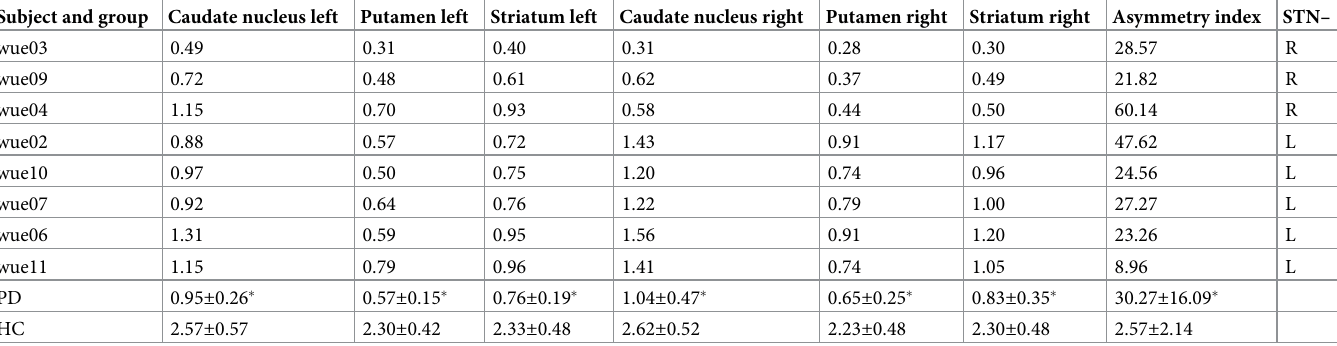
Table 3. Non-displaceable binding potentials of dopamine reuptake